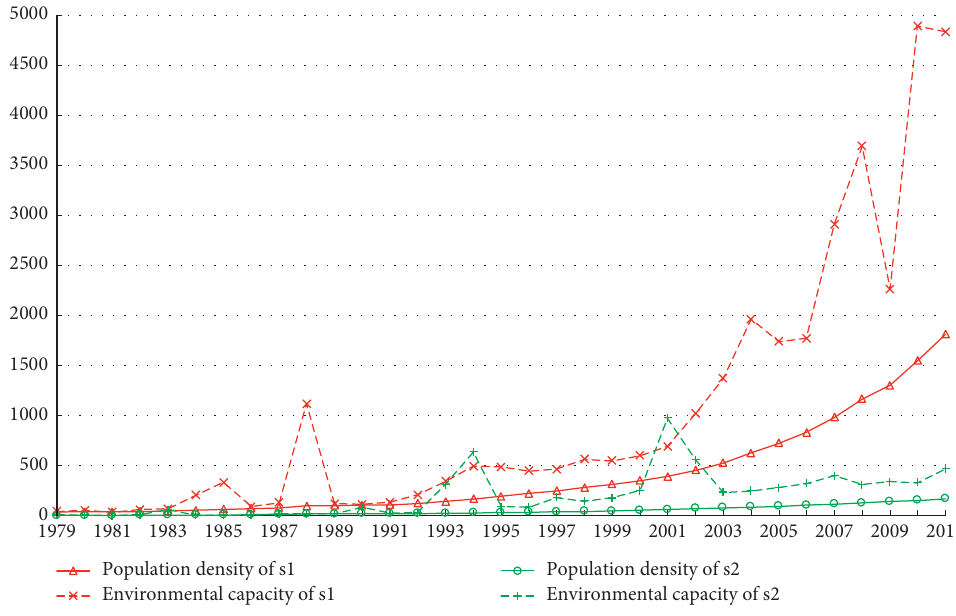
Figure 2: The relationship between S